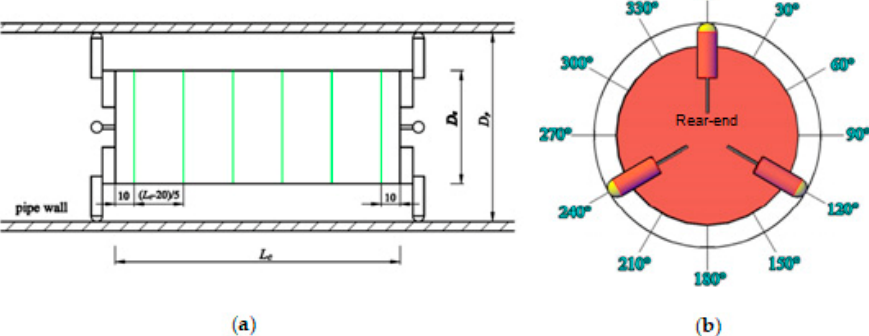
Figure 7. Distribution of capsule-stress-measuring points. ( a ) Test section of wall stress; ( b ) Measuring points for each section of wall stress.